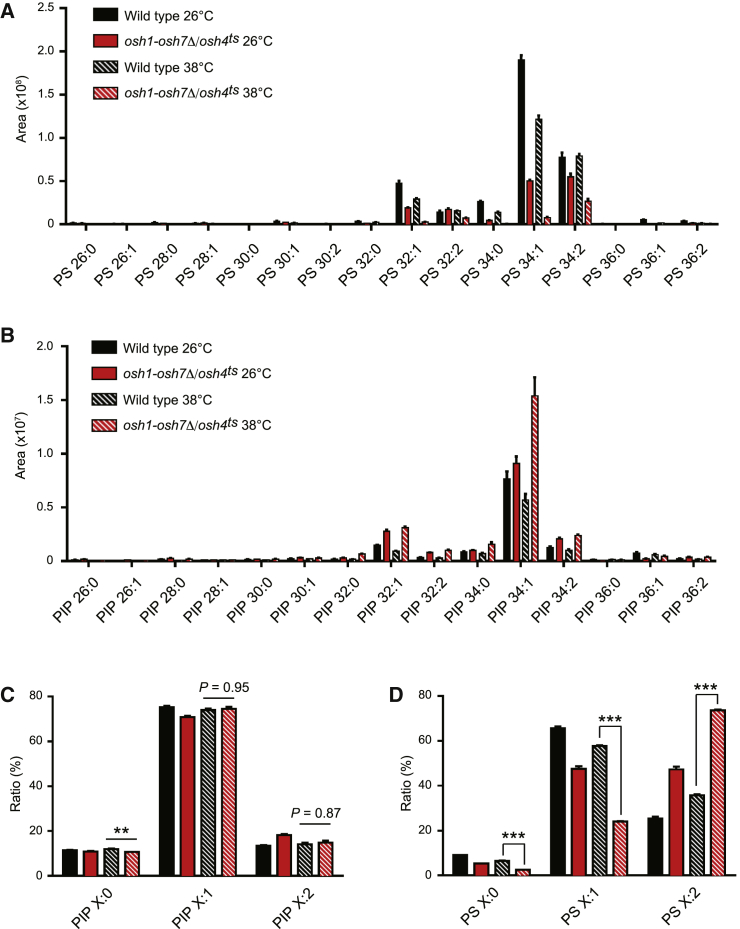
Fatty Acid Unsaturation of PIP and PS Are Maintained in osh1-7Δ/osh4ts CellsLipidomic analysis of PS and PIP in wild-type and osh1-7Δ/osh4ts cells cultured at 26°C or 38°C for 2 h. Data represent mean ± SEM (n = 5).(A and B) Fatty acid compositions of PS (A) and PIP (B).(C and D) Fatty acid unsaturation degree of PIP (C) and PS (D).∗∗p < 0.01, ∗∗∗p < 0.001. See also Figure S4.